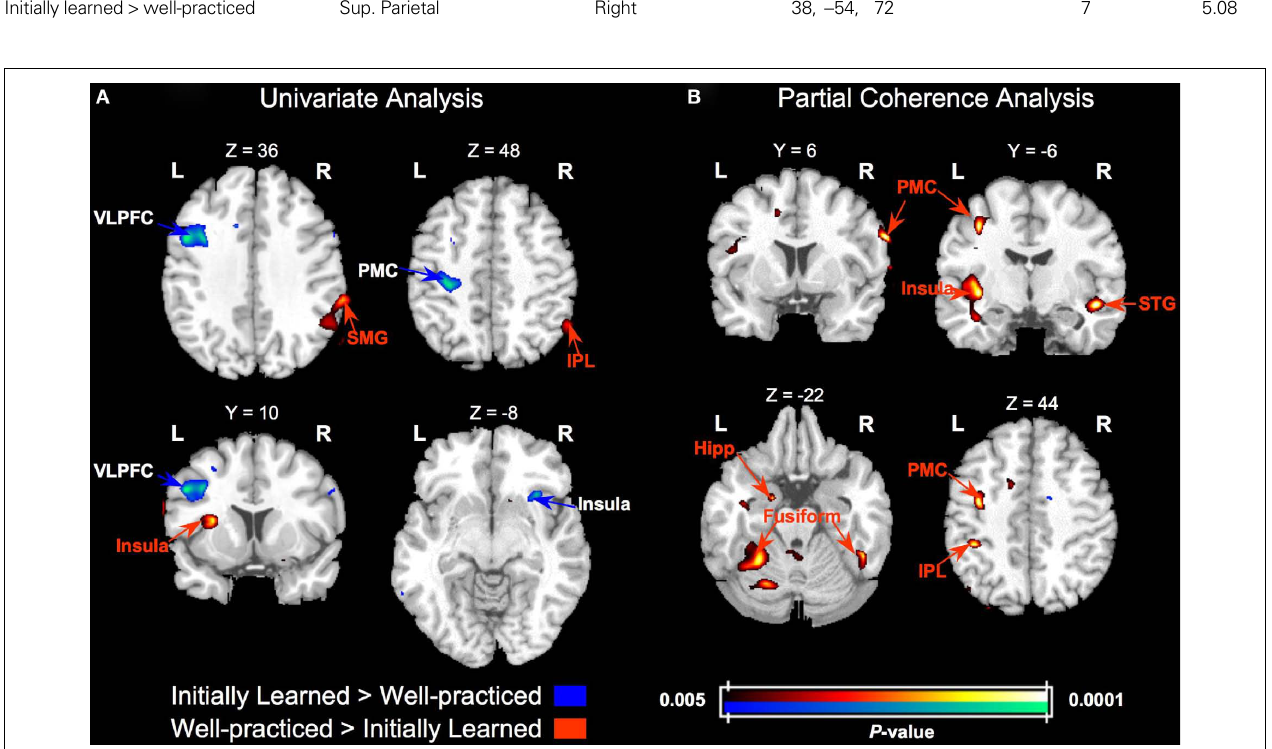
FIGURE 5 | Group activity and partial coherence differences between categorization with initially learned versus well-practiced tasks. (A) Statistical parametric t maps contrasting activity in the initially learned task and well-practiced task blocks. (B) Statistical parametric t maps contrasting partial coherence with the